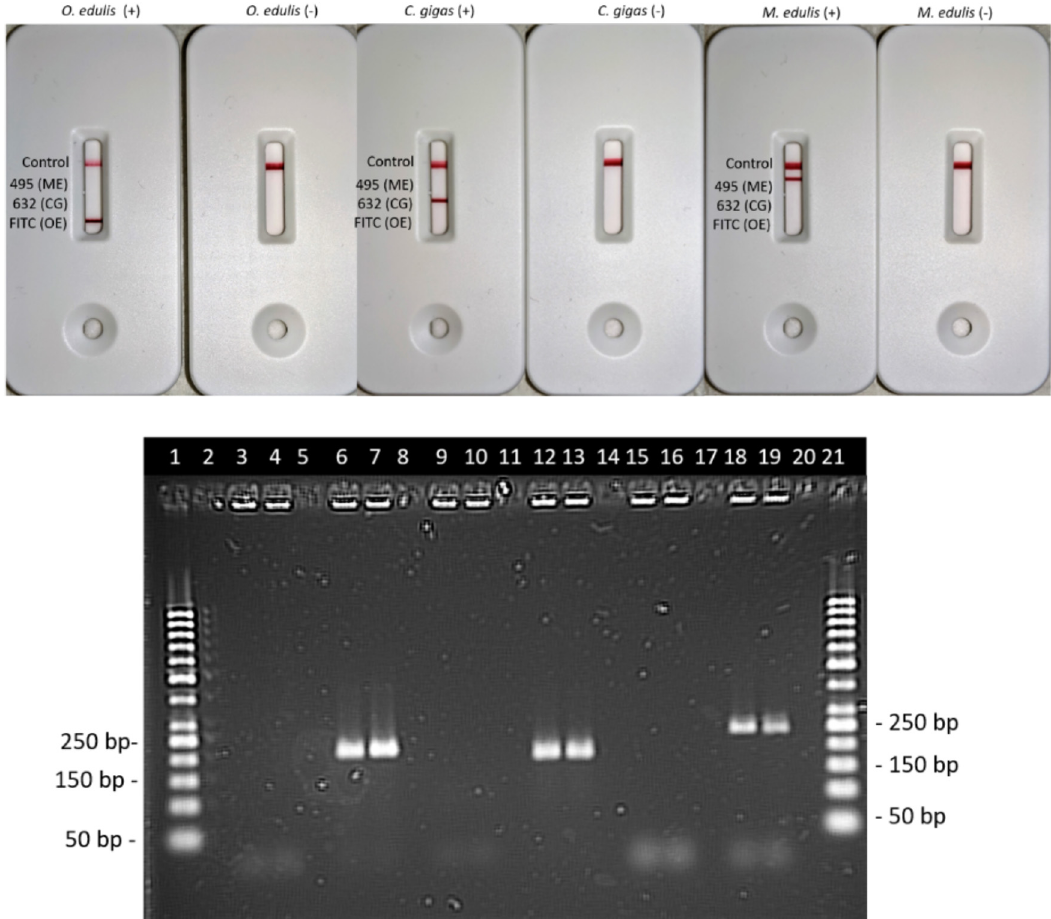
Fig. 2. PCR-nucleic acid lateral fl ow immunoassay (NALFIA) with a combination of a single primer pair and a single DNA template. The respective DNA template is indicated above each cartridge. The ( þ ) is indicating the positive control, ( (cid:2) ) is indicating non-template control. The labelontheleftsideofeverypairofcartridgesisindicatingthetestlinefortheexistenceof Ostreaedulis (FITCOE), Crassostreagigas (632CG),and Mytilus edulis (495 ME). The most upper line on the cartridges is indicating the control line of each NALFIA. The image of the 3% agarose gelelectrophoresisgelshowsthequalitycontrolofthePCRproduct.Theschemeofthegelslots:1:50bpmarker,2:empty,3:OExnegativereplicate 1, 4: OE x negative replicate 2, 5: empty, 6: OE x O. edulis replicate 1,7: OEx O. edulis replicate 2, 8: empty, 9: CG x negative replicate 1, 10: CG